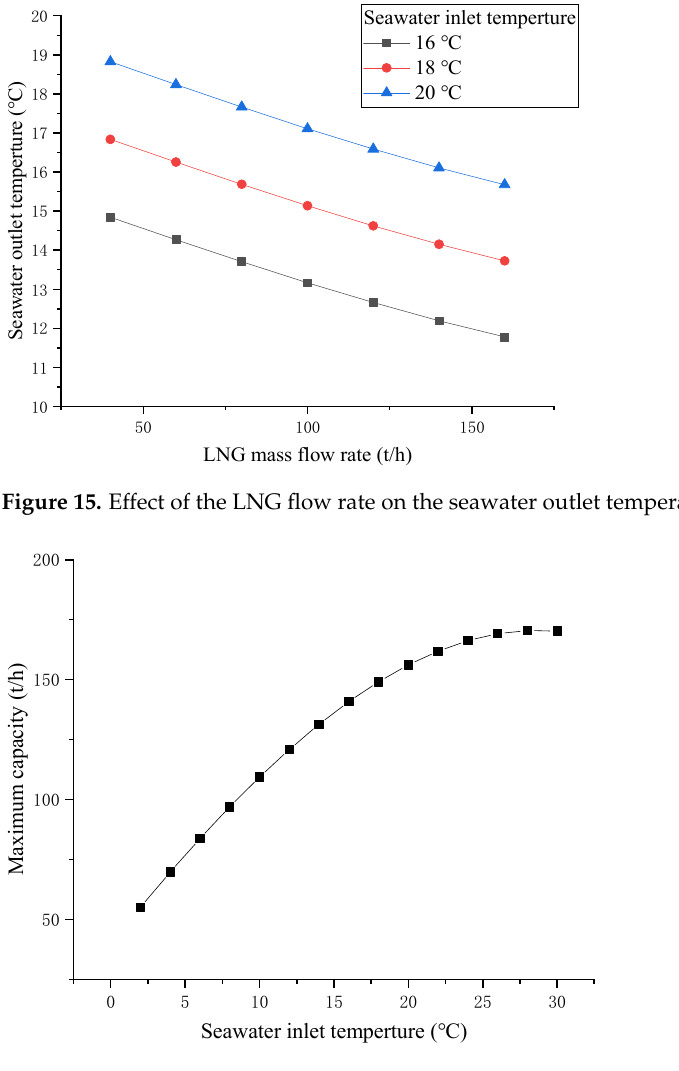
Figure 16. The maximum LNG handling capacity of the IFV at different seawater temperatures.